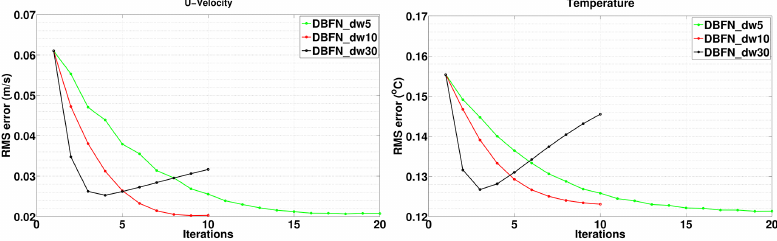
Figure 9. Evolution of the initial condition rms errors for the zonal velocity and temperature during the DBFN iterations over the first assimilation cycle, for three DAw: 5, 10 and 30 days.